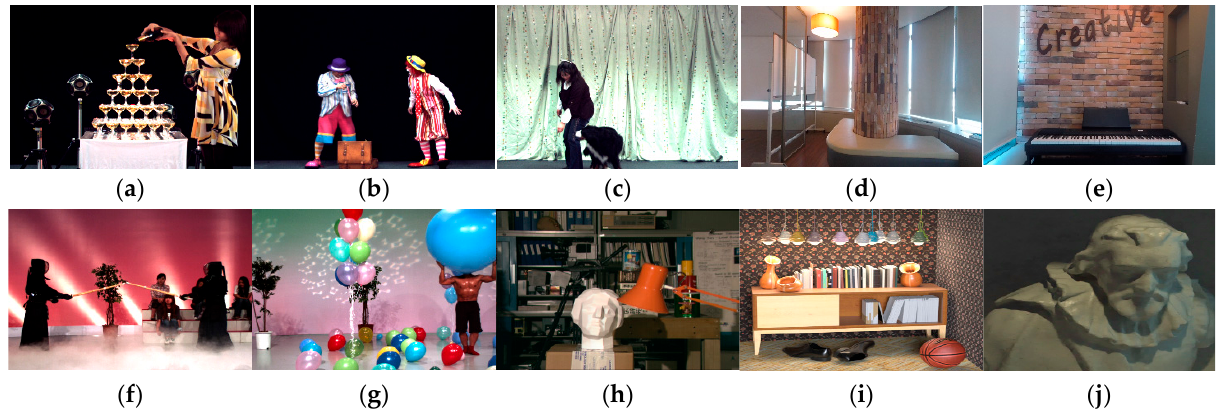
Figure 4. Dataset. ( a ) Champagne; ( b ) Pantomime; ( c ) Dog; ( d ) Wall; ( e ) Piano; ( f ) Kendo; ( g ) Balloons; ( h ) Ohta; ( i ) Sideboard; ( j ) Cotton.